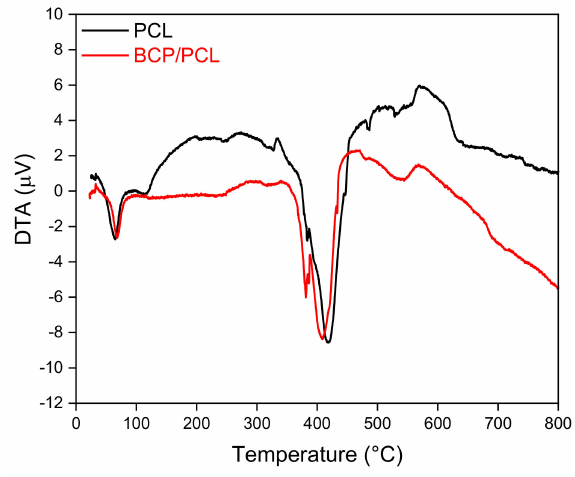
Figure 15. Differential thermal analysis (DTA) curves of PCL and BCP/PCL mixture up to 800 ◦ C (heating rate 10 ◦